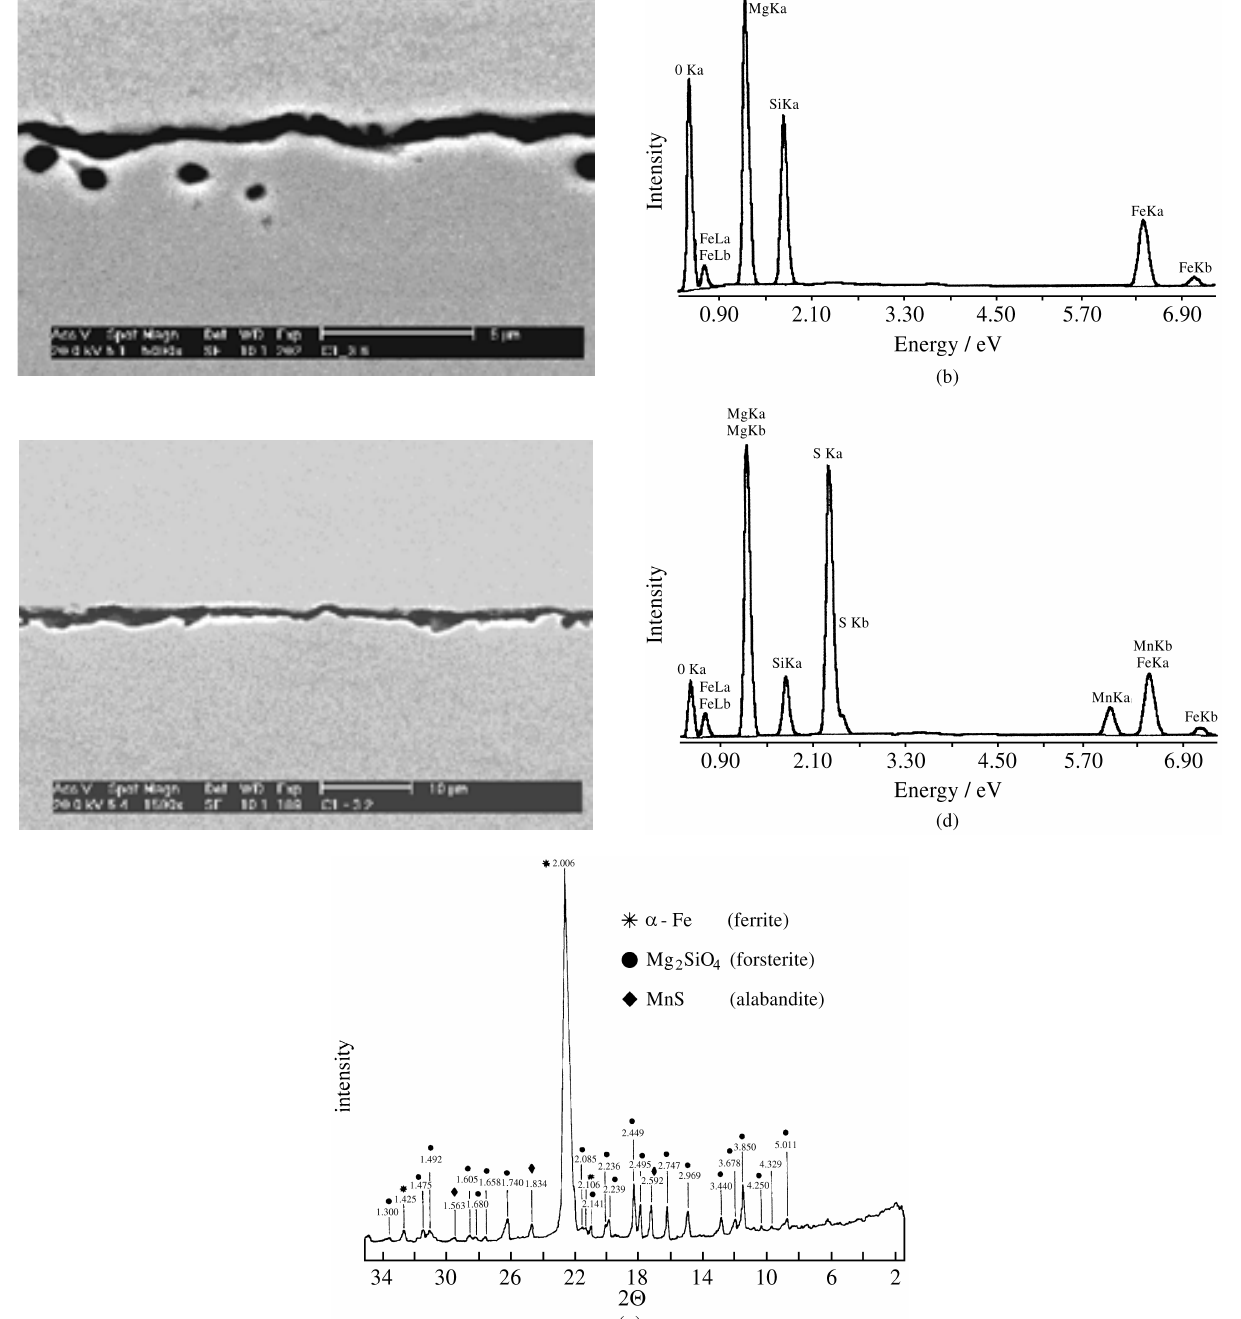
Figure 3. Typical oxide layer formed with the MgO + 1% Sr slurry deposition. (a) 5000X. (b) EDS spectrum obtained for the continuous layer; (c)